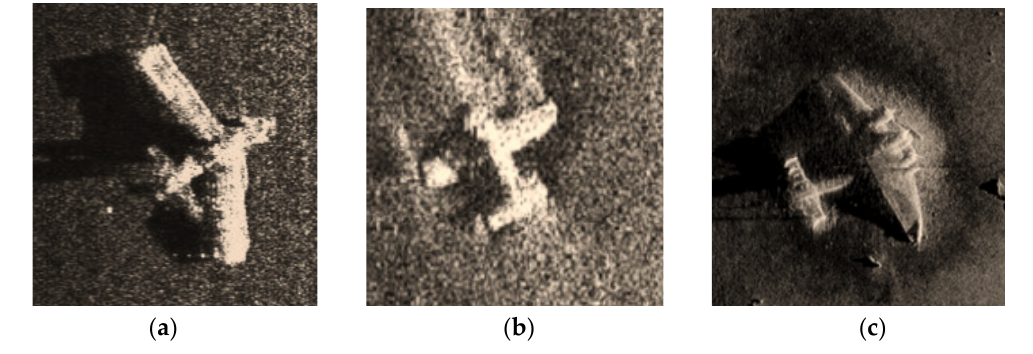
Figure 13. ( a – c ) Images after redefining the size of the aircraft. Table 5. Using the trained weights in Tables 3 and 4 to predict Figure 12a–c.